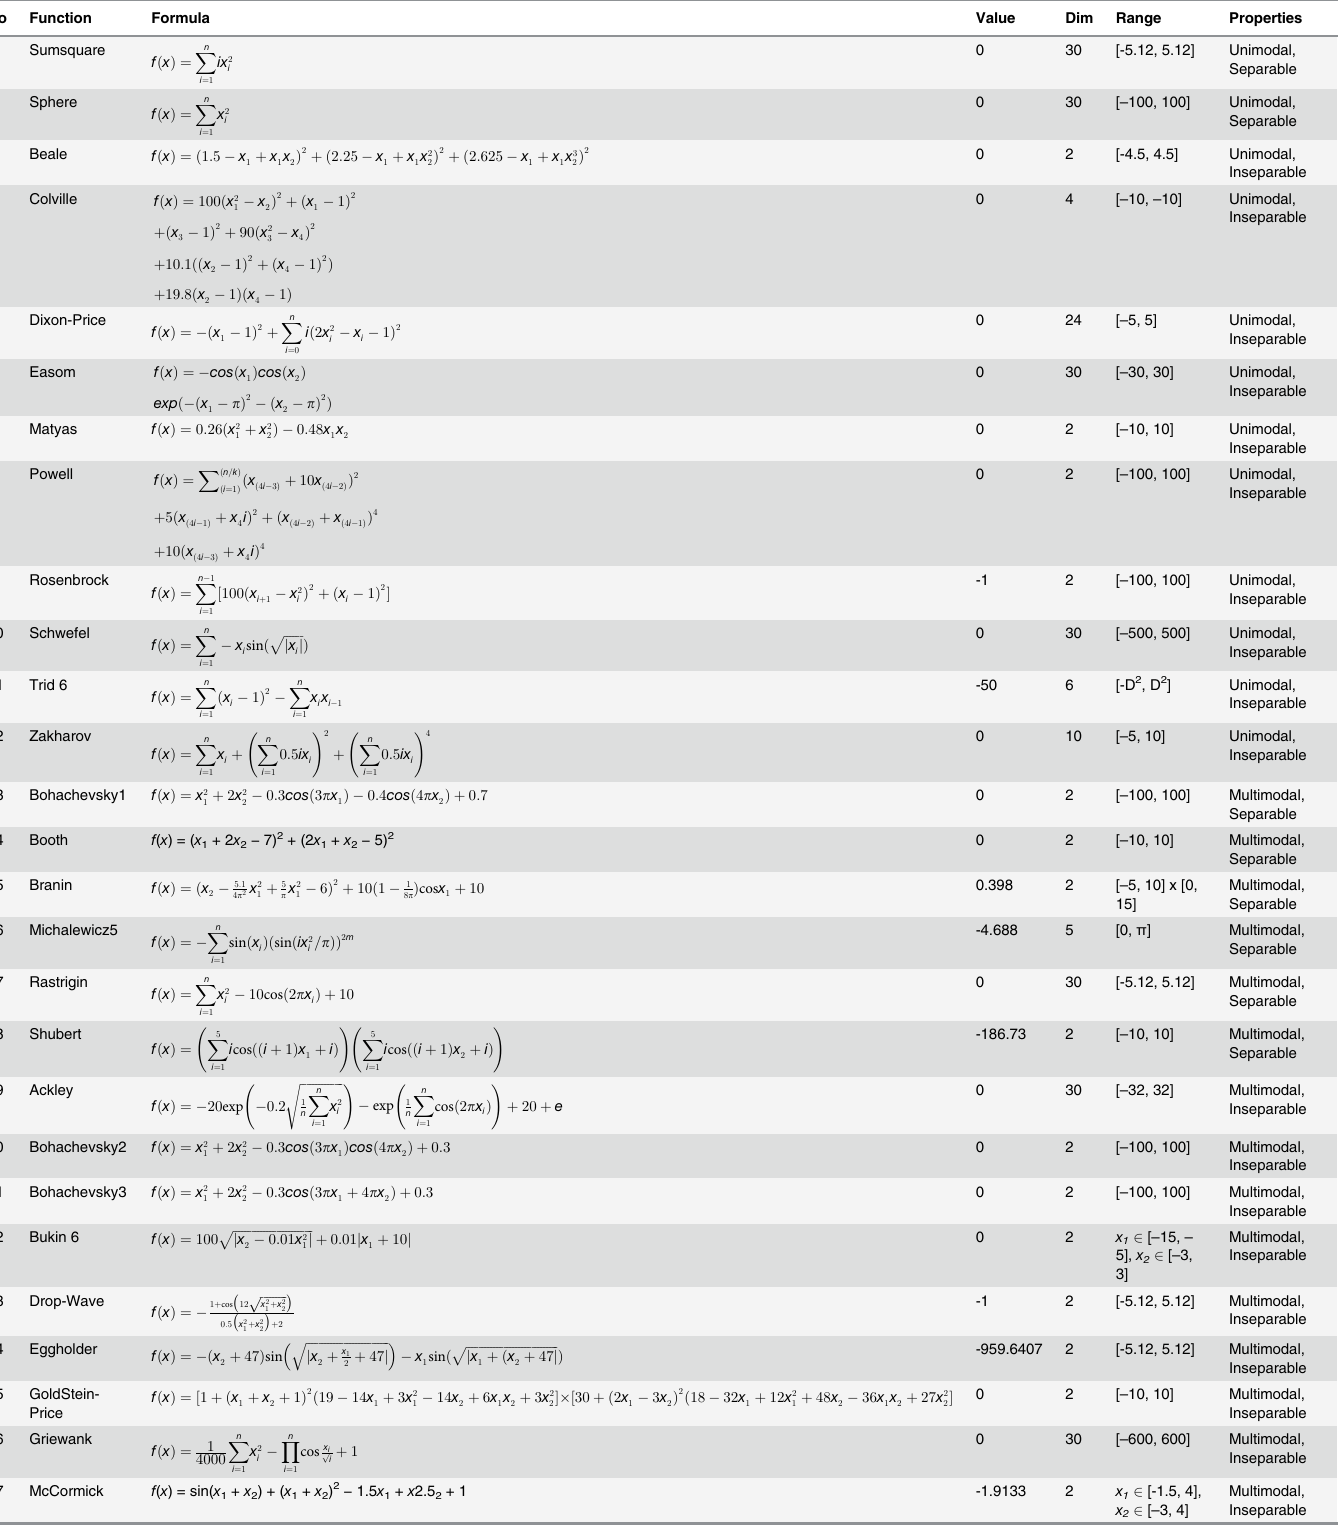
Table 2. Benchmark Functions Selected for